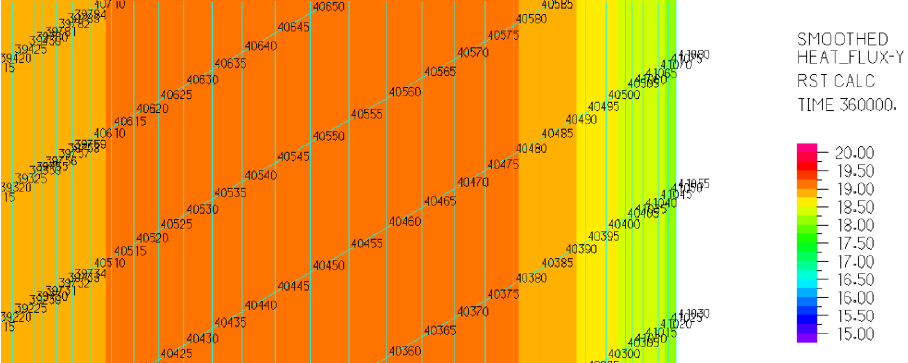
Figure 9. View of the nodes on the inner surface of the element.